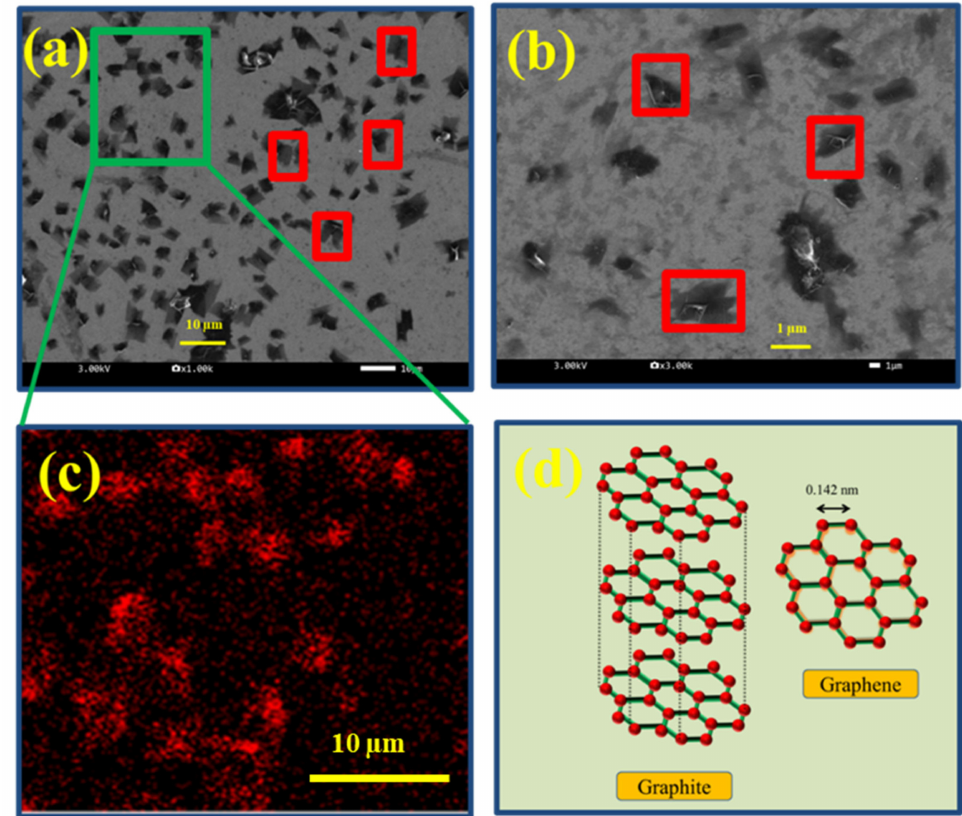
Figure 1. SEM images of graphene flakes drop casted on silicon wafer at ( a ) 10 µ m magnification scale, ( b ) 1 µ m magnification scale, ( c ) EDS mapping showing carbon and ( d ) illustration of graphite and graphene